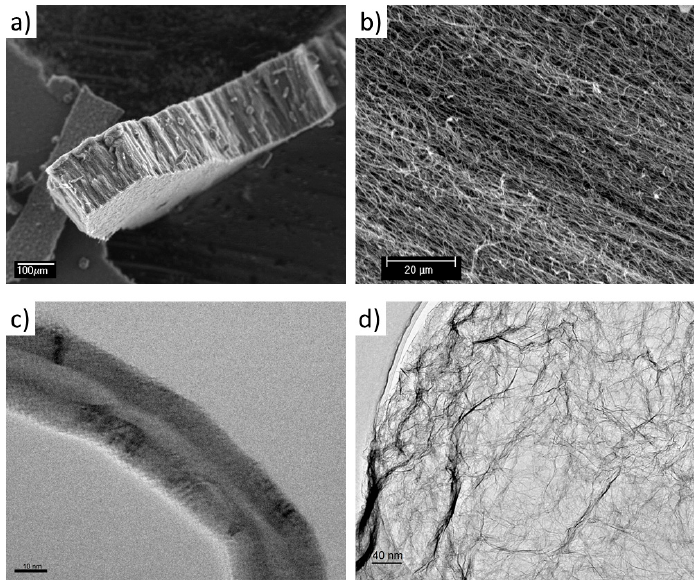
Figure 2. Morphology of in-house synthesized nanoparticles: ( a ) and ( b ) SEM and ( c ) TEM images of MWCNTs, ( d ) TEM image of TRGO.